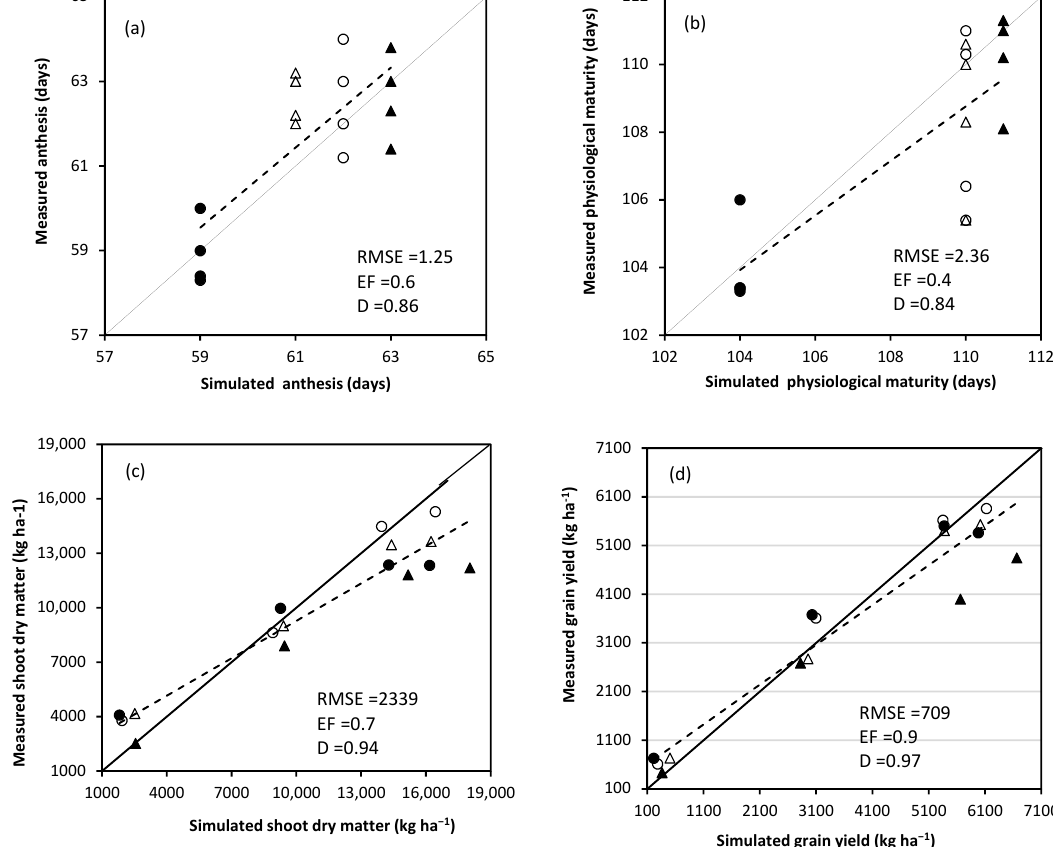
Figure 4. Comparison of simulated and measured anthesis ( a ), physiological maturity ( b ), grain yield at maturity ( c ) and shoot dry matter at maturity ( d ) for SAMMAZ-15 using Iburu and Zaria experimental data sets. (Iburu = ▲ 2015, ○ 2016 and Zaria = ● 2015, Δ 2016, the plants were grown under four N treatments within each location and date).